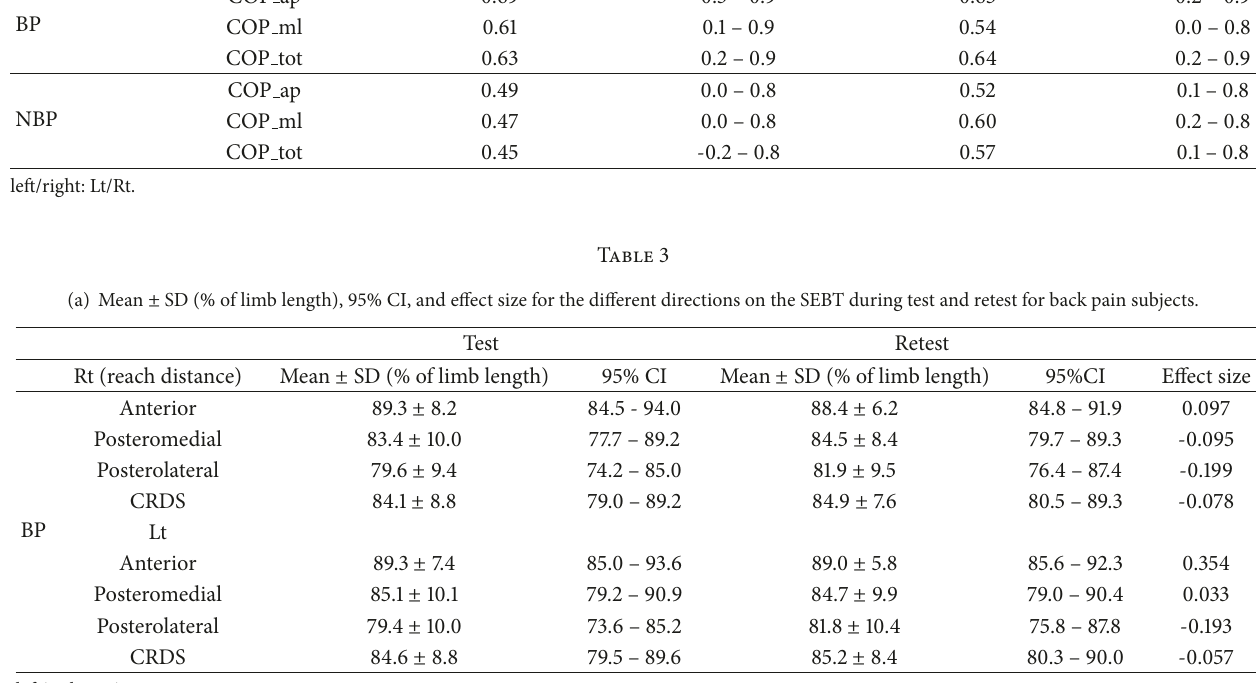
Table 2: Intraclass correlation coefficients with 95% confidence interval for the one-legged stance test calculated for testretest reliability for BP and NBP.